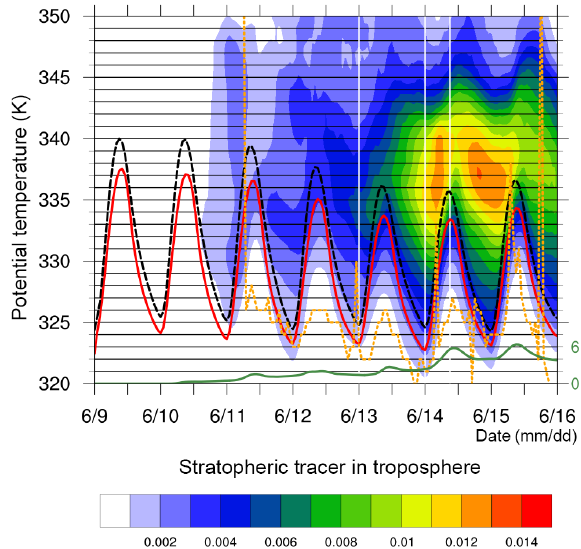
Figure 8. Time series the same as in Fig. 7 but for the Tibetan Plateau STT event from 9 to 16 June 2006. The white vertical lines denote the times shown in Figs. 5 and